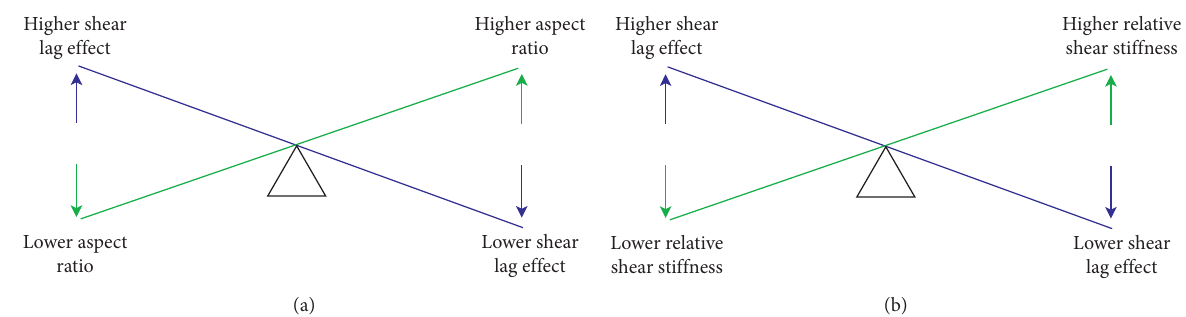
Figure 8: (a) Shear lag against aspect ratio. (b) Shear lag against relative shear stiffness.